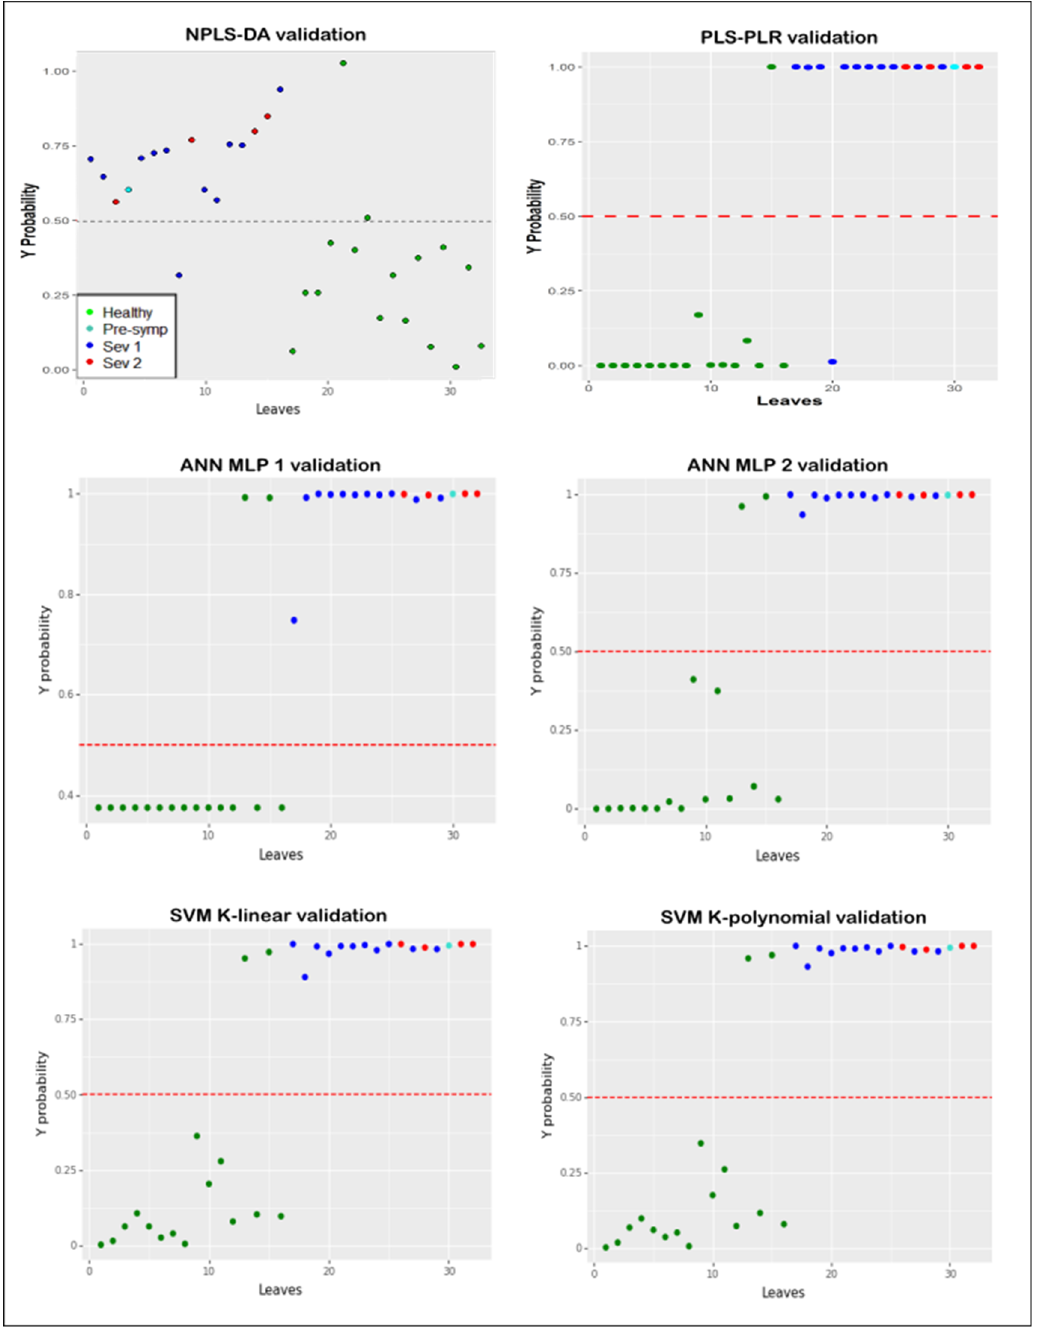
Figure 3. Estimated probability of infection from external validation of the models.